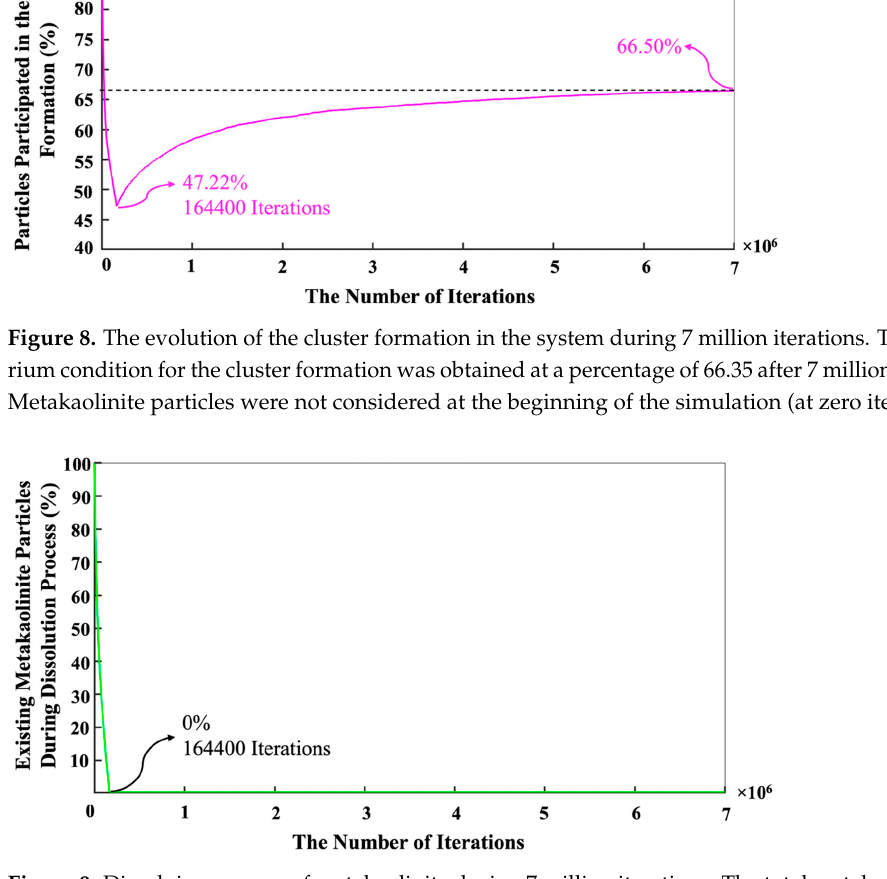
Figure 9. Dissolving process of metakaolinite during 7 million iterations. The total metakaolinite was dissolved after 164400 iterations.